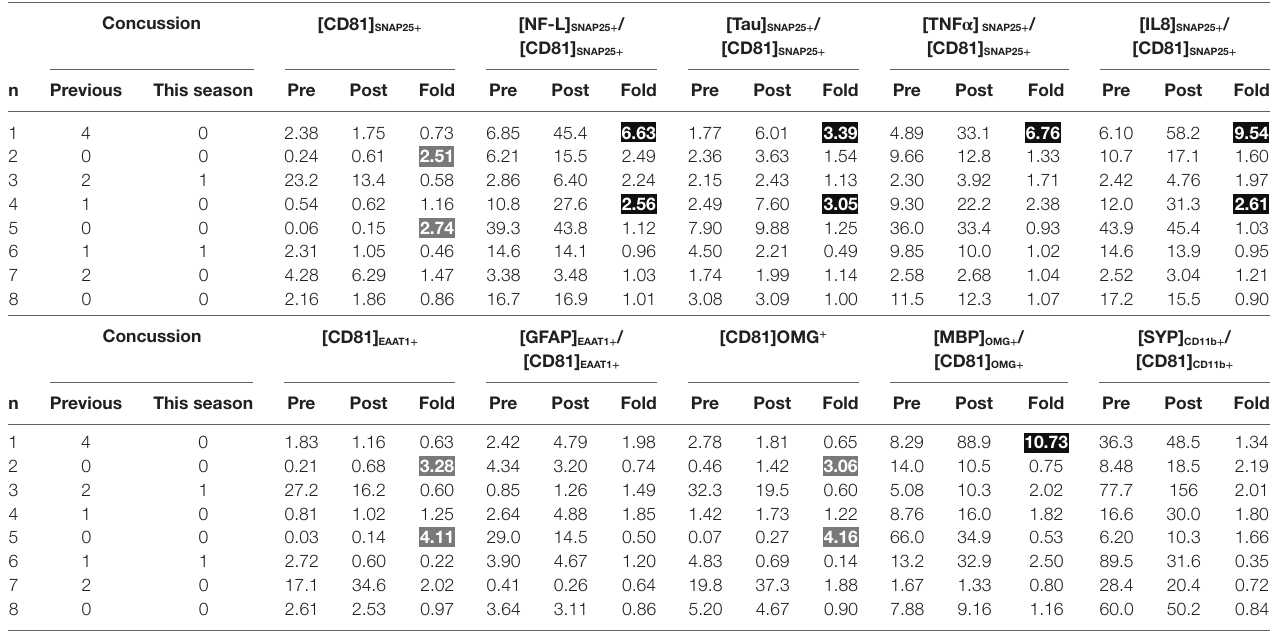
TaBle 3 | Individual profiles of biomarker expressions between pre- and post-season (dark shade, drastic increase possibly due to brain trauma; gray shade, increase not related to brain trauma).